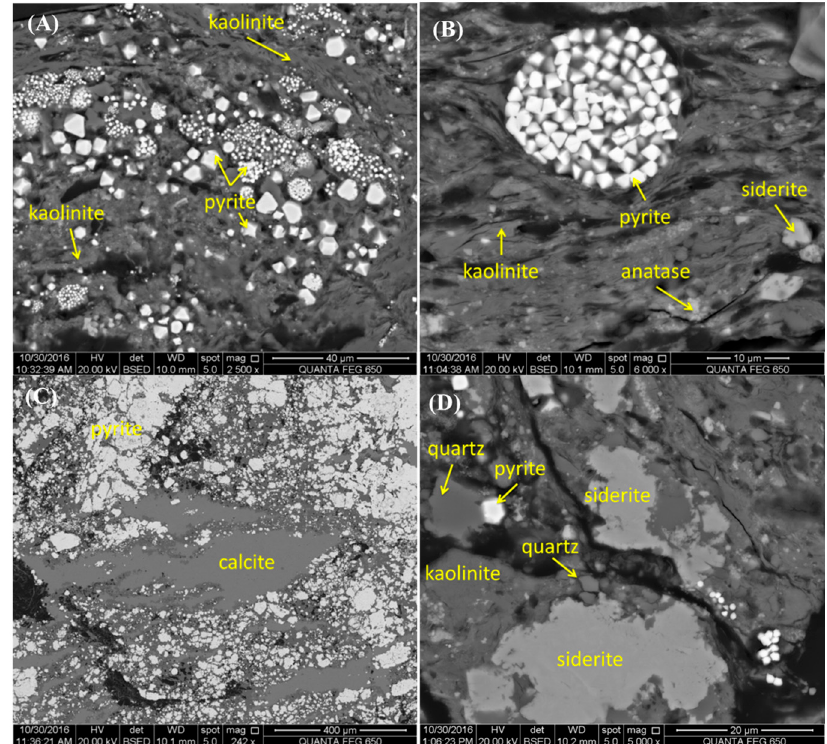
Figure 11. Pyrite in the SGT1-11 sample. ( A ) Framboidal and euhedral pyrite in kaolinite matrix; ( B ) framboid with euhedral pyrite crystals; ( C ) massive pyrite connected with calcite; ( D ) single euhedral pyrite. SEM back-scattering images.